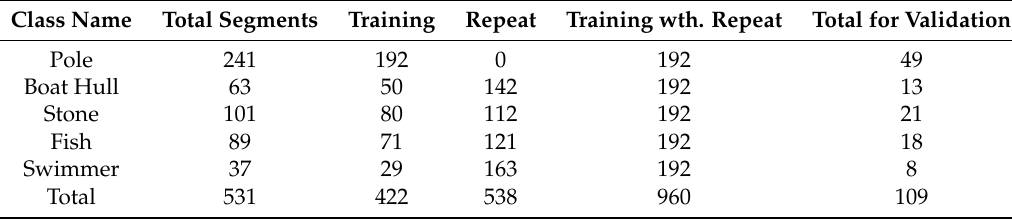
Table 1. Dataset